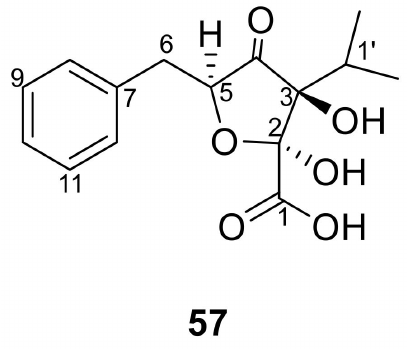
Figure 16. Botrycinereic